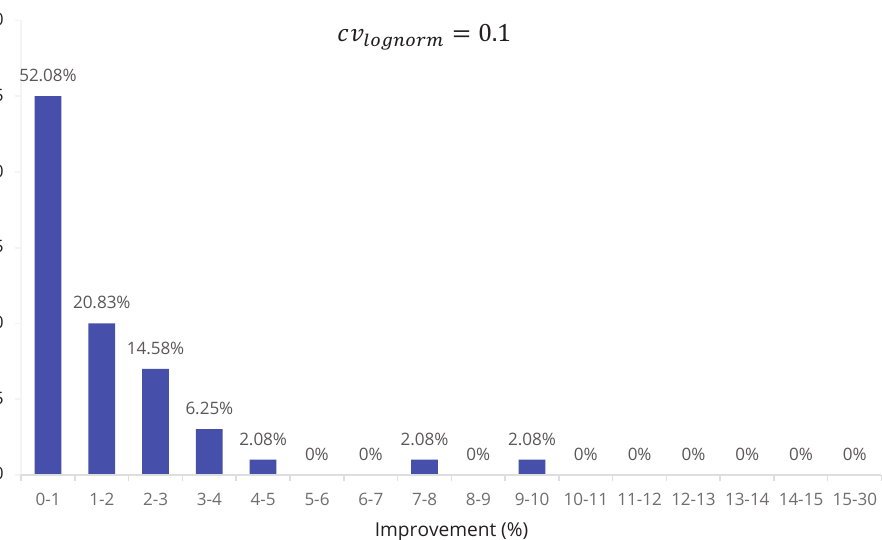
Figure 8. Performance of the genetic algorithm: comparison between best value initial population and best value last generation of optimization cv lognorm = 0.9.